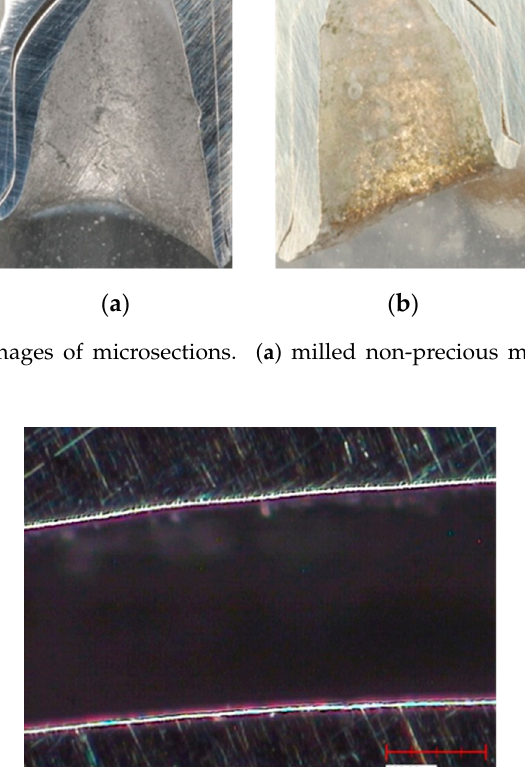
. Figure 6. Cut surface of cast Au telescope, occlusal gap ~110 µm and comparatively wavy shape of the inner surface of the secondary crown. Figure 7. Cut surface of milled non-precious metal telescope (lingual, complete contact surface at parallel milling).